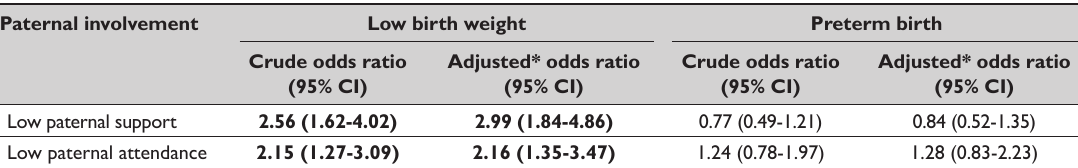
Table 3:Relationship between paternal involvement and low birth weight/ preterm birth Paternal